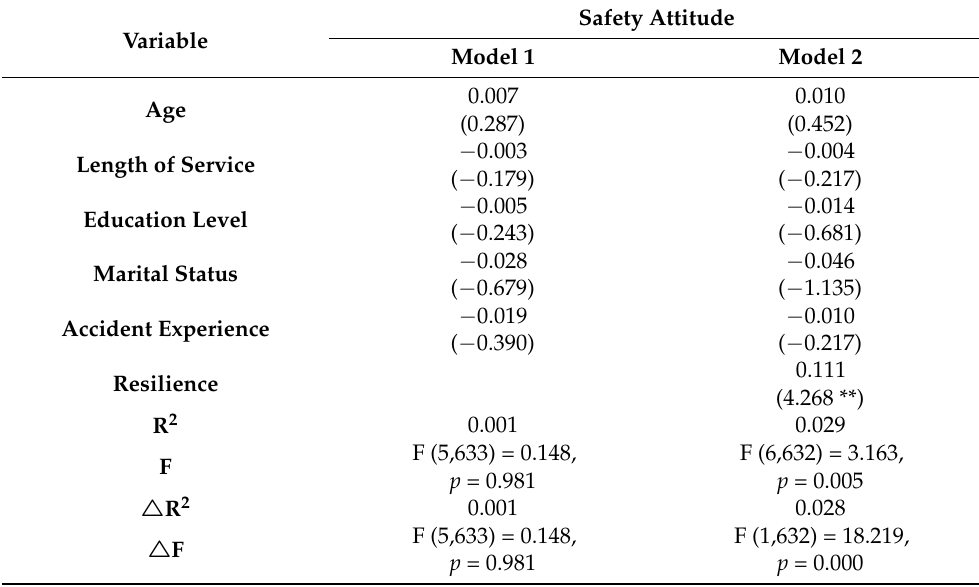
Table 11. Regression analysis of resilience on safety attitude (N =